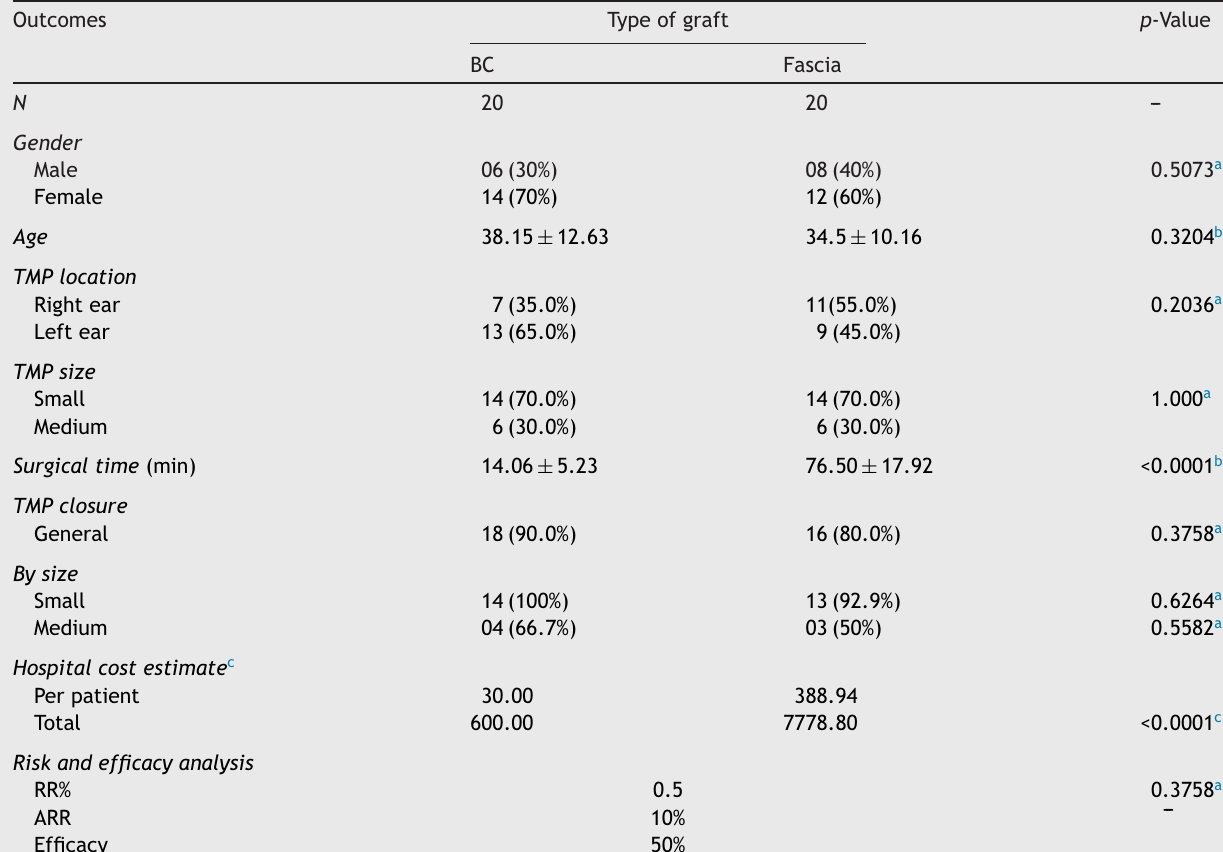
Outcomes evaluated between groups treated with bacterial cellulose and autologous fascia grafts, for treatment of perforated tympanic membrane.